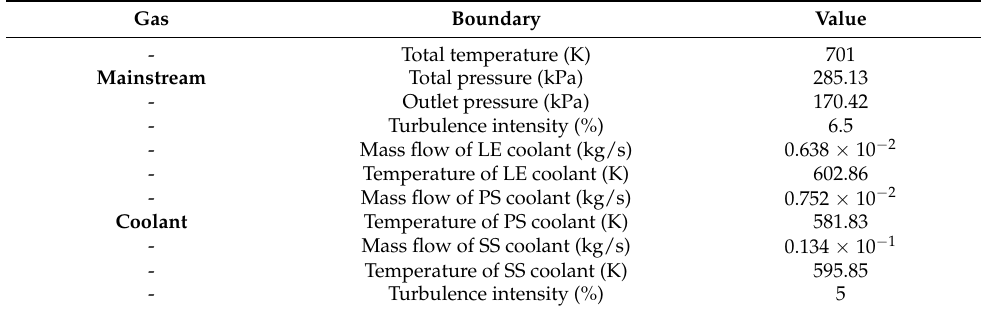
Table 2. Boundary conditions.